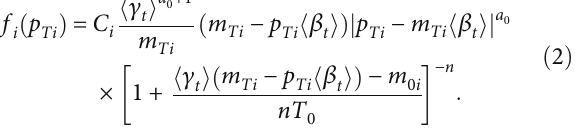
ffiffiffiffiffiffiffiffiffiffiffiffiffiffiffiffi p p 2 + m 2 T